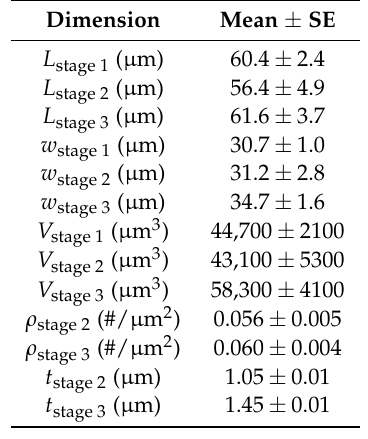
Table 1. Measured principal dimensions and feature sizes of elongated VND7-inducible cells in the 3 stages of transdifferentiation. Length ( L ), width ( w ), and thickness ( t ) of SCW bundles are measured using image processing. Volume ( V ) is calculated from measured length and width, assuming cells are cylindrical in shape. The density of SCW bundles ( ρ ) is calculated by counting the number of bundles observed in a particular cell, and dividing by the cross-sectional area in the